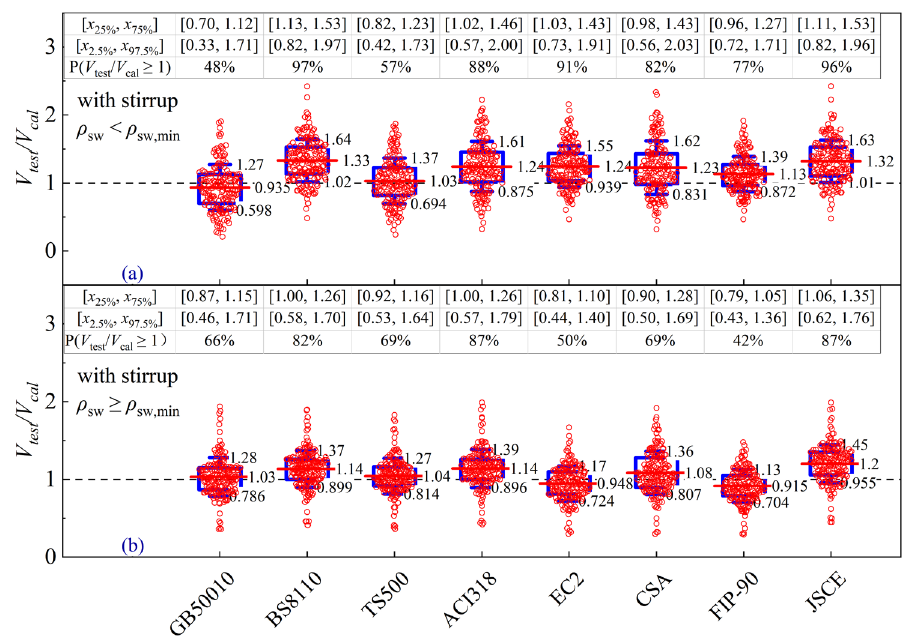
Figure 16. Codes: prediction results versus ( a ) ρ sw < ρ sw,min and ( b ) ρ sw ≥ ρ sw,min .